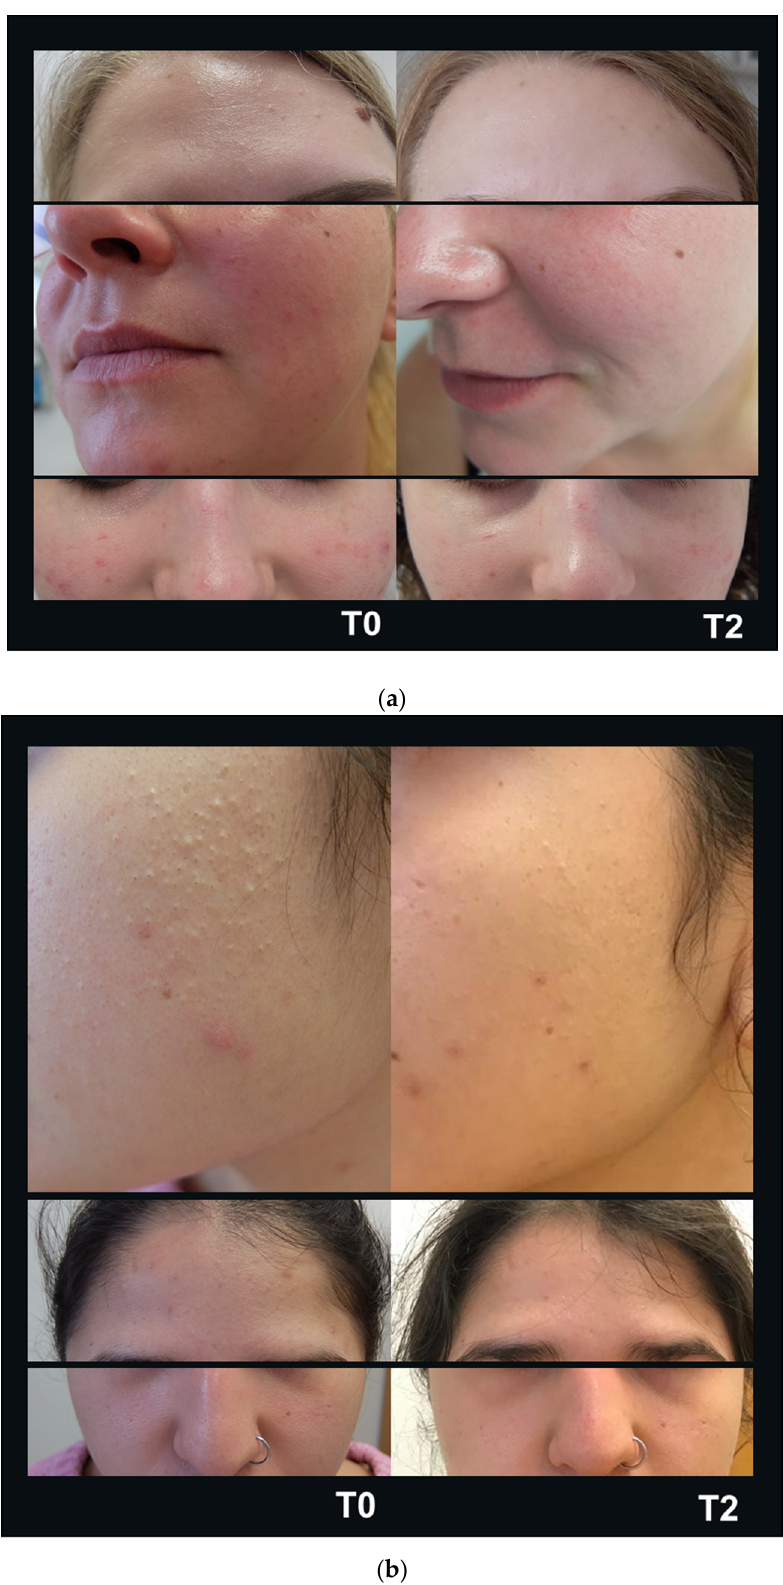
Figure 3. Improvement of acne vulgaris. Eight weeks of nitric oxide (NO)-producing gel formulation treatment (T2) reduced the amount of closed and open comedones and inflammatory pustulae in mild ( a ) and moderate ( b ) acne resulting in a purer skin texture.